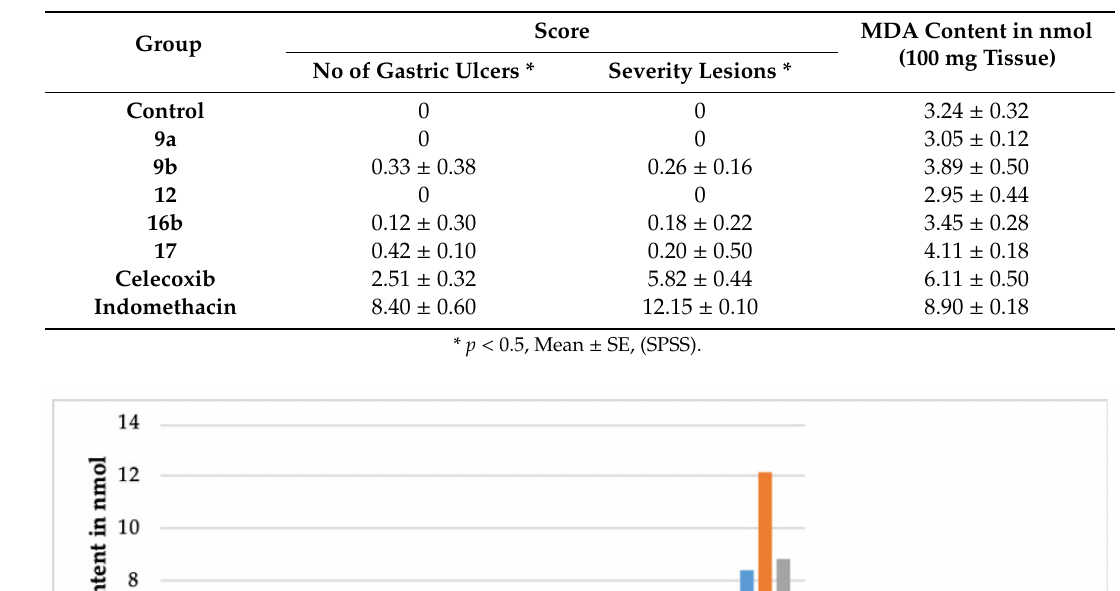
Table 3. The gastric safety profile of 9a , 9b , 12 , 16b , and 17 .